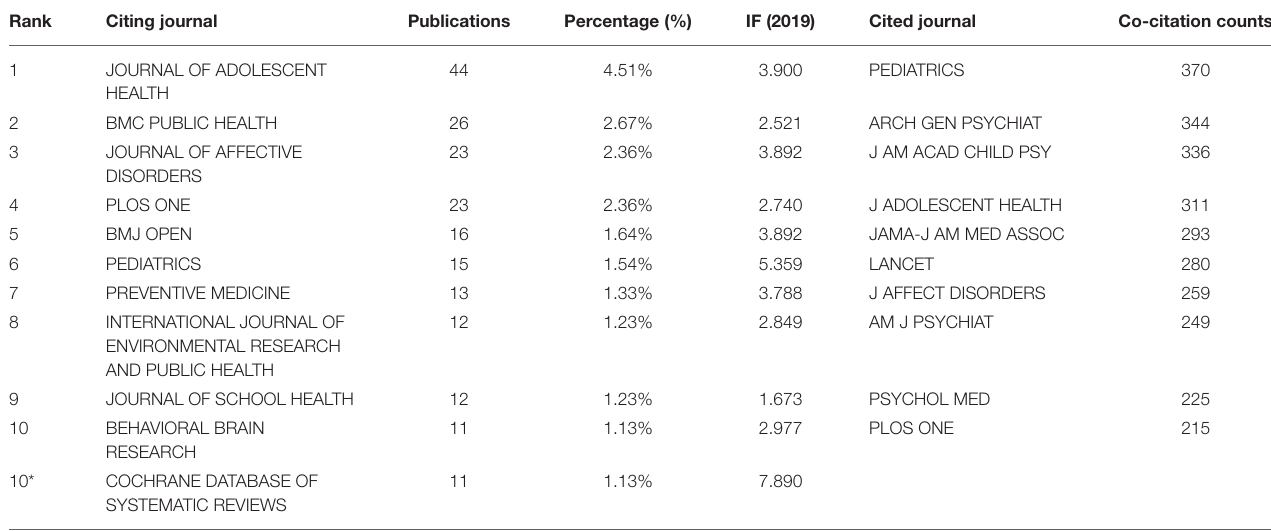
TABLE 2 | Ranking of top 10 journals and co-cited journals in the field of exercise-depression-teenager research from 2000 to 2020. Rank